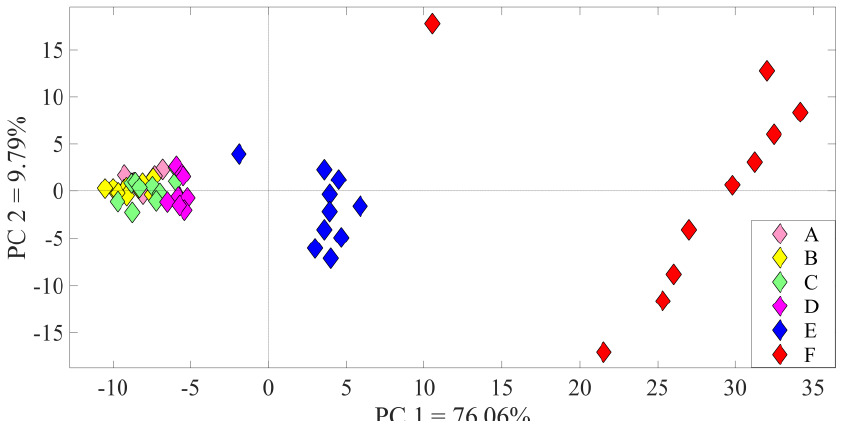
Figure 10. PCA was based on the covariance matrix of the observations. For each individual recording, PC1 and PC2 were kept, analyzed, and plotted. In the frontal cortex, each dot represents an ECoG epoch with an amplitude variation. The covariance matrix highlights a greater degree of dispersion with each increase in intensity. The legend refers to the Protocol Stimulation described in Figure 9.